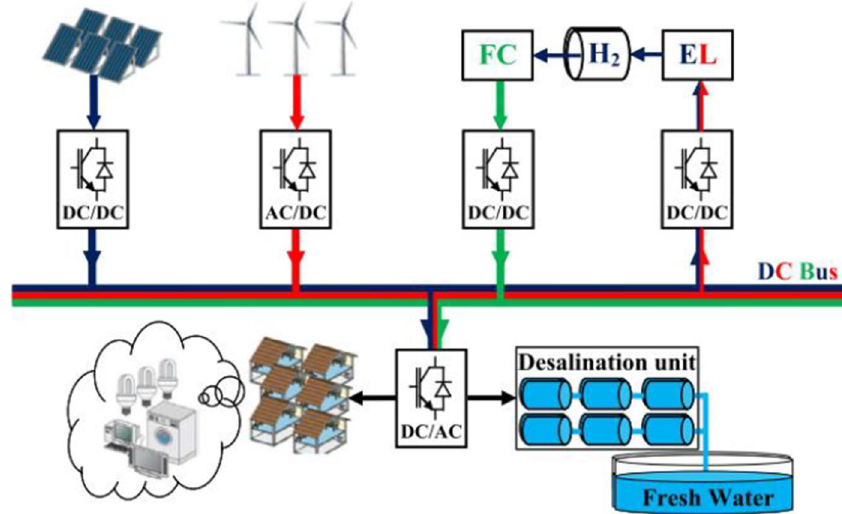
Fig. 34 The hybrid system is driven by wind, PV and hydro- gen for the desalination process (Smaoui et al. 2015)